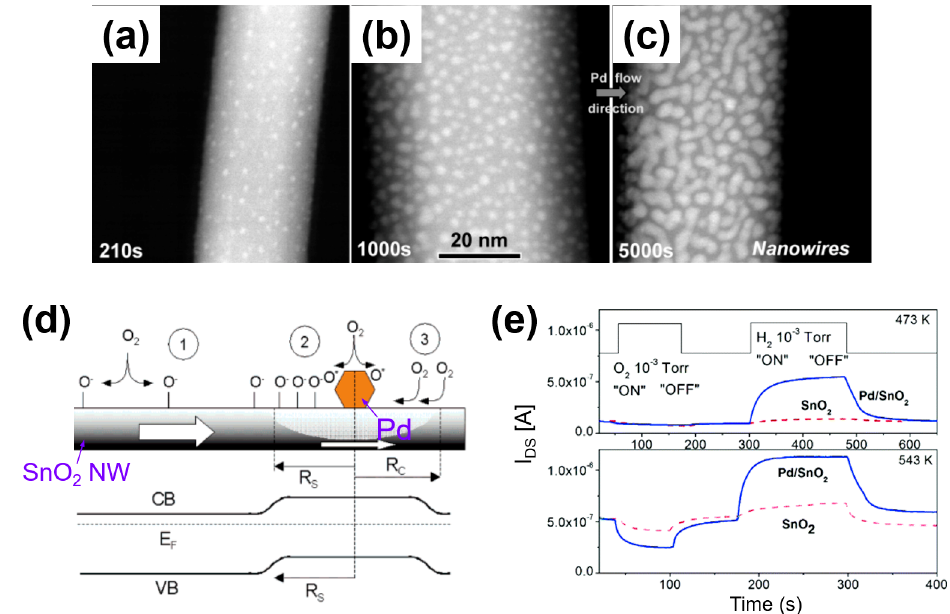
Figure 18. ( a – c ) Nanoparticles decorated metal–oxide nanowire with different coverage; ( d ) schematic depiction of the three major processes taking place at a SnO 2 nanowire surface and their band diagram; and ( e ) compared studies of the sensing performance of SnO 2 and SnO 2 /Pd nanowire sensor devices. Reprinted from reference [273] with permission from the American Chemical Society.